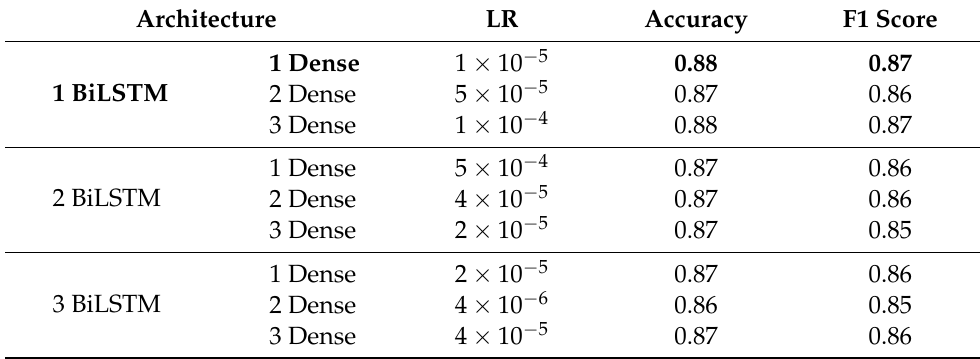
Table 11. Comparing BiLSTM-based classifier results using the BERT